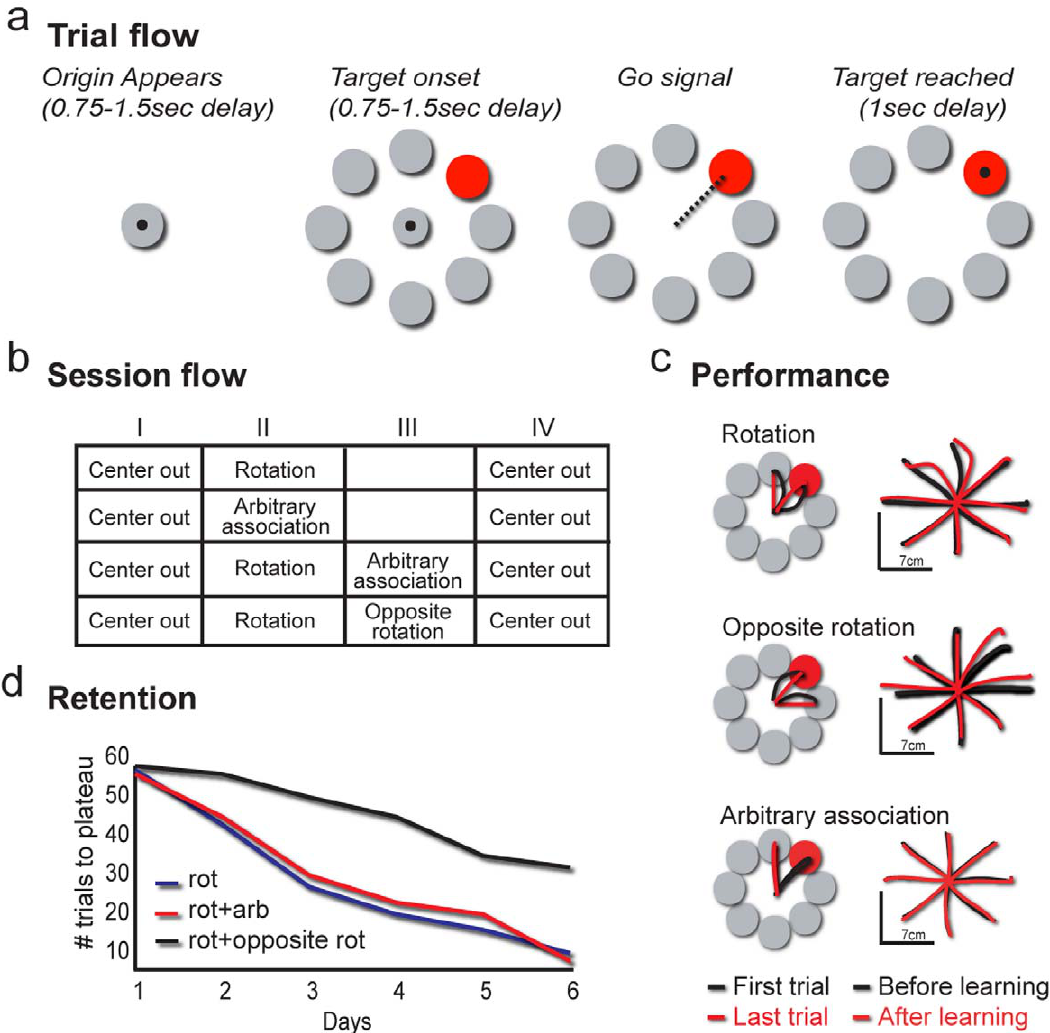
Figure 1. Experimental design and behavioral results. a) Trial flow (left to right): Each trial, in all tasks, always began with the cursor in the central origin. Following a 750–1500 ms delay, 8 targets appeared, 7 white (on a black screen), one colored (target onset; TO; the color was blue, green, red, or magenta). Following a second 750–1500 ms delay the origin disappeared, cueing movement (GO signal). Primates had to reach the target within 1000 ms and hold the curser steady at the target circle for 1000 ms. (b) Session flow. The subjects performed a block of 200 trials of center-out task before and after the novel (learning) task, which was either rotation alone, arbitrary association alone, rotation followed by arbitrary association or rotation followed by the opposing rotation task. Each block comprised 200 trials, each trial according to the trial design in 1a (c) Task performance in the different tasks. Left: example of the first trials performed during learning of rotation (top), rotation followed by opposite rotation (middle; second rotation) or arbitrary association (bottom); each task included only two movement directions. Right: examples of performance during the center-out task before and after learning the novel task. (d) Retention of the rotation task. Measured by the number of trials to reach 100% performance, for monkey M. Black lines represent retention after sessions of rotation alone; red, retention after sessions where rotation was followed by arbitrary association; and blue, retention after session where rotation was followed by opposite rotation. Note that retention after opposite rotation was slower than retention in other